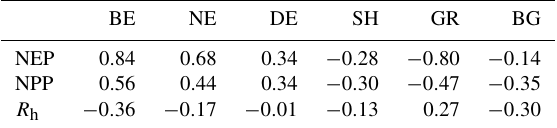
Table 4. Pearson correlation coefficients between carbon fluxes (NEP, NPP, R h ) and percentage changes in vegetation cover for broadleaf evergreen (BE), needleleaf evergreen (NE), deciduous (DE), shrub (SH), grass (GR), and bare ground